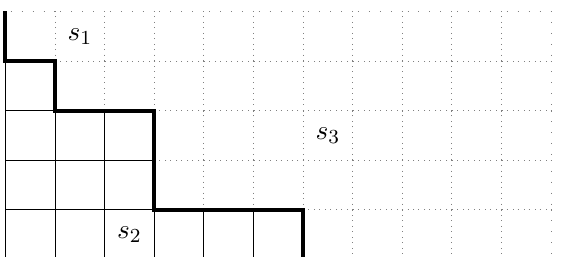
Figure 1. Arm and leg length with respect to the Young diagram whose borders are outlined by dark black: A ( s coordinate ( i, j ) of the box s